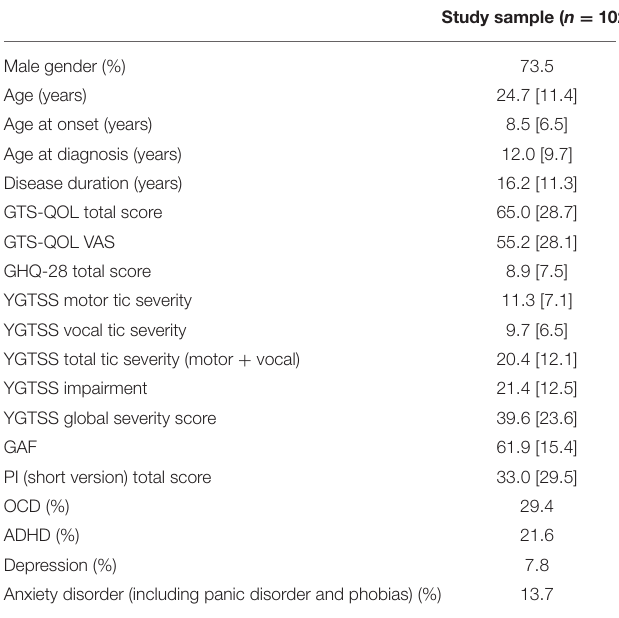
TABLE 1 | Basic characteristics of the study